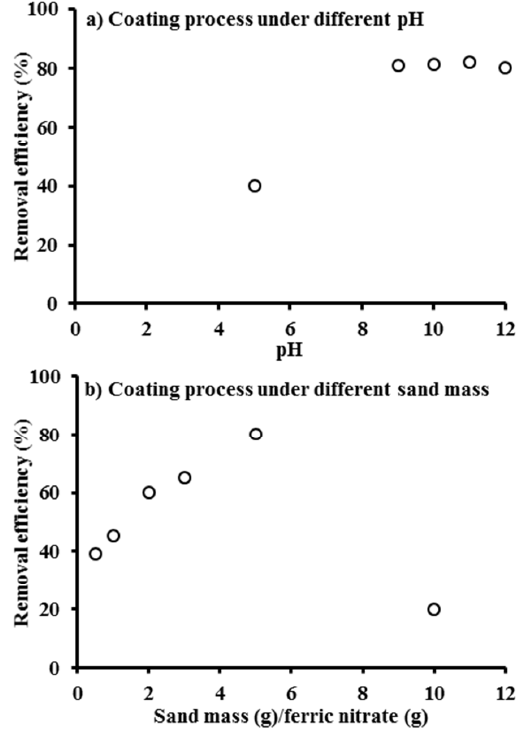
Fig. 2. Effect of a) pH and b) sand mass on the Cd(II) removal efficiency onto